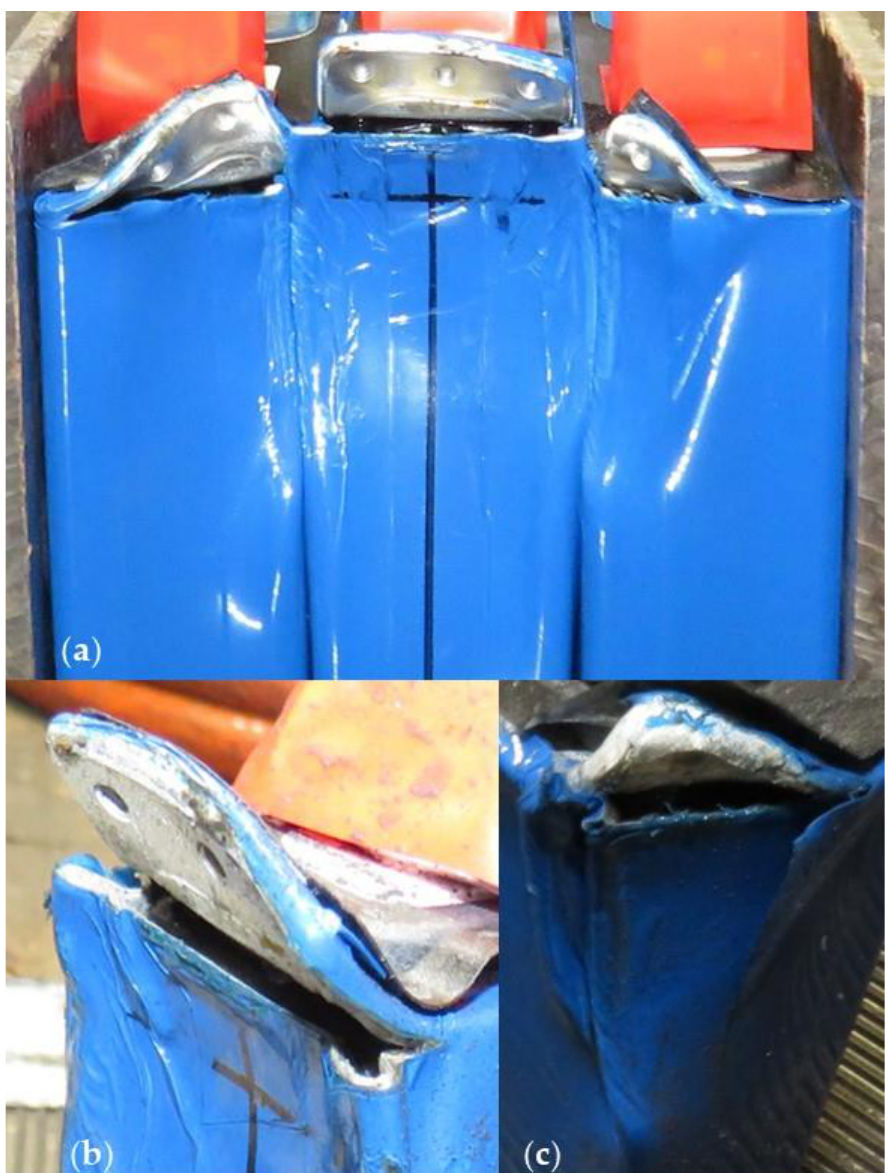
Figure 7. Deformation of cells after test QT06 (v-direction hemispherical impactor), ( a ) at test rig, ( b ) middle cell after test and ( c ) right cell after test.